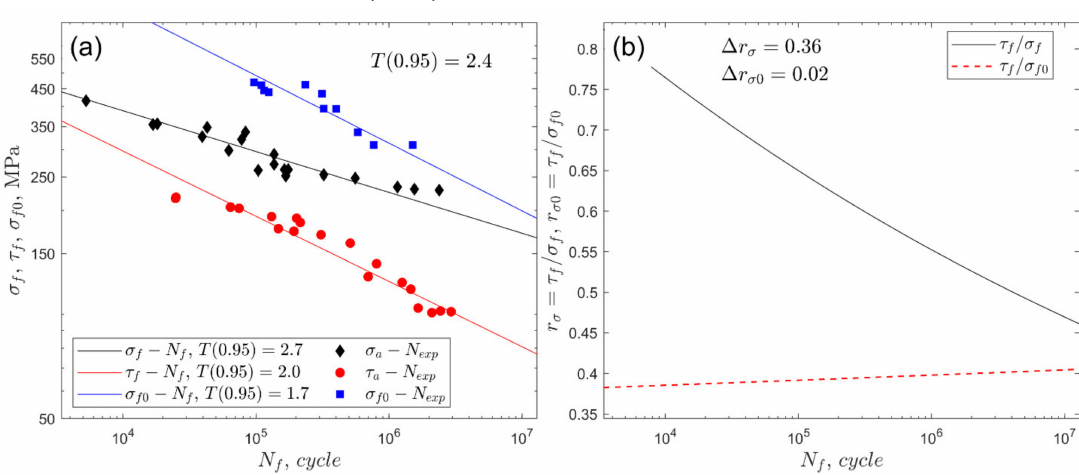
Figure 3. ( a ) Fatigue characteristics of the aluminium alloy 7075-T651 for fully reversed bending σ f − N f